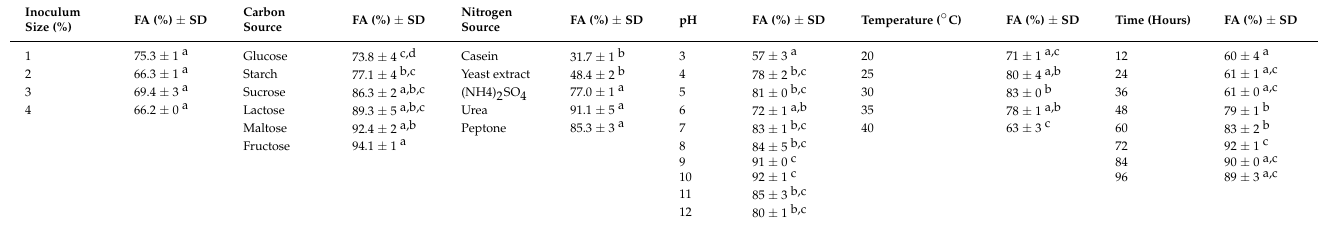
Table 2. Effect of inoculum size, carbon and nitrogen sources, pH, temperature and time on